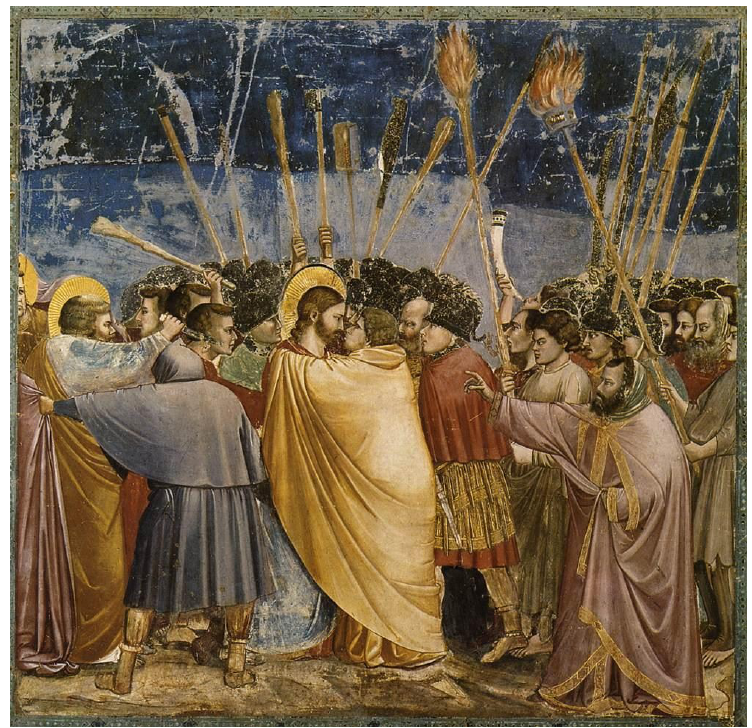
Figure 13. Arrest of Christ (c. 1304–06). By Giotto. Arena Chapel, Padua. Photograph from Wikimedia and flagged for noncommercial use.